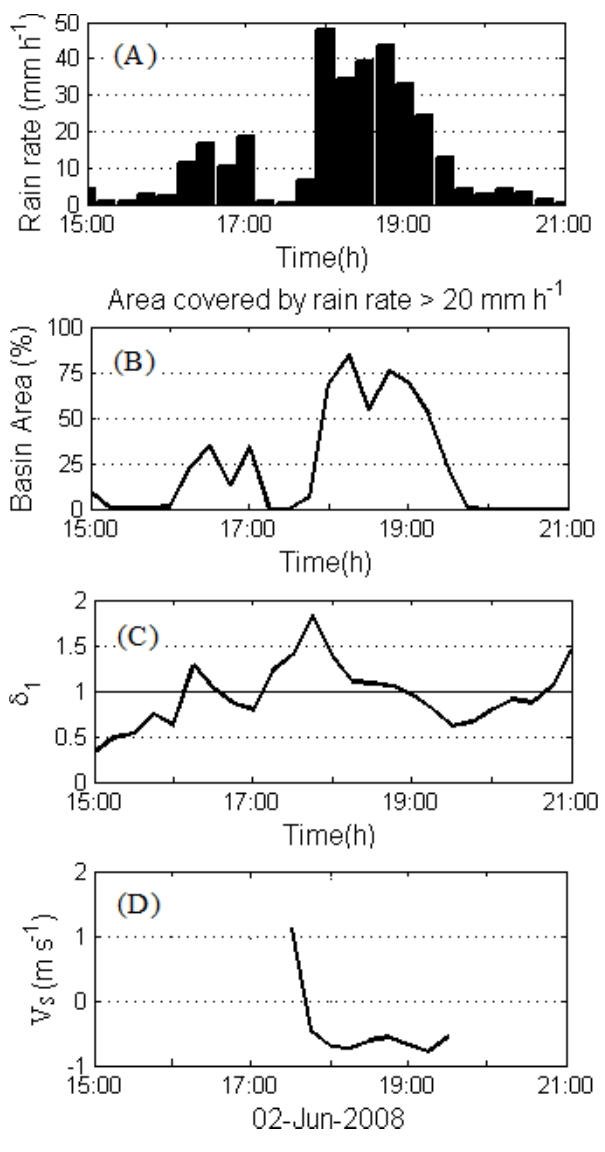
Fig. 7. Starzel catchment at Rangendingen: precipitation analy- ses by using 15-min time series of (a) precipitation intensity, (b) percent coverage of the catchment (for precipitation intensity > 20mmh − 1 ) , (c) δ 1 , (d) catchment scale storm velocity.